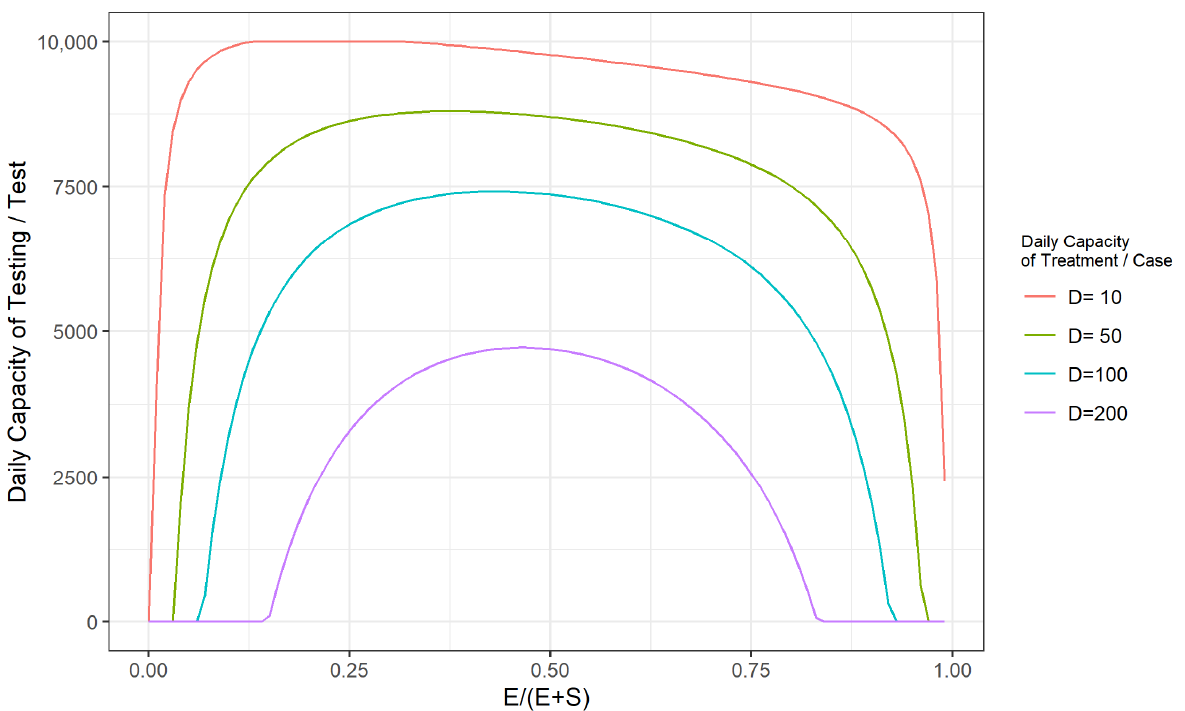
Figure A12. The effect of daily testing capacity on the ability to control the potential development level of the epidemic ( S + E = 2000, I = 1000).